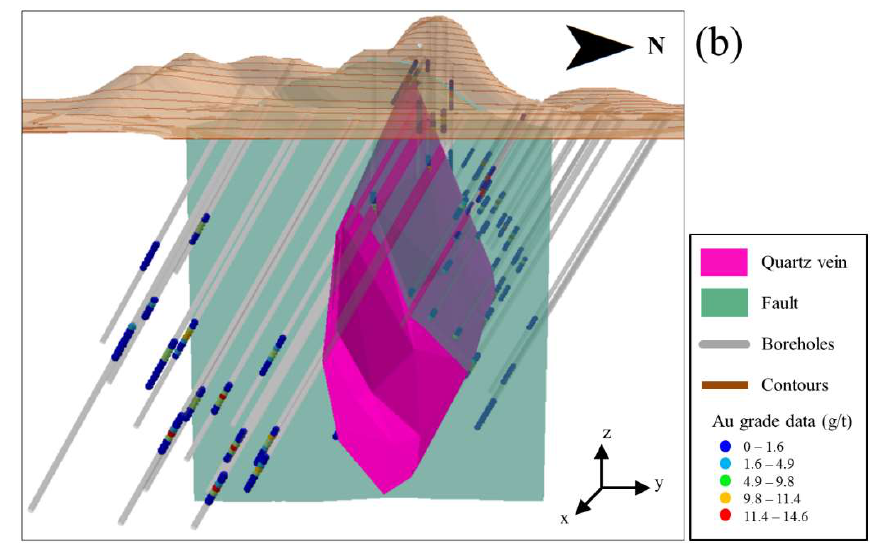
Figure 1. ( a ) 2D map and ( b ) 3D model of quartz vein, fault, boreholes, and composited Au grade sample of the Au deposit.